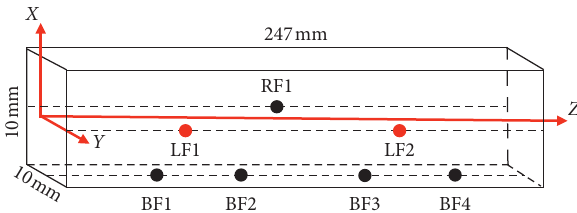
Figure 14: Typical dimensions and position of longitudinal strain gauges (black) and temperature sensors (red) on the specimens. Longitudinal strain gauges are referenced by a BF (bottom face) or RF (right face) notation, and thermal probes are referenced by an LF (left face) notation.